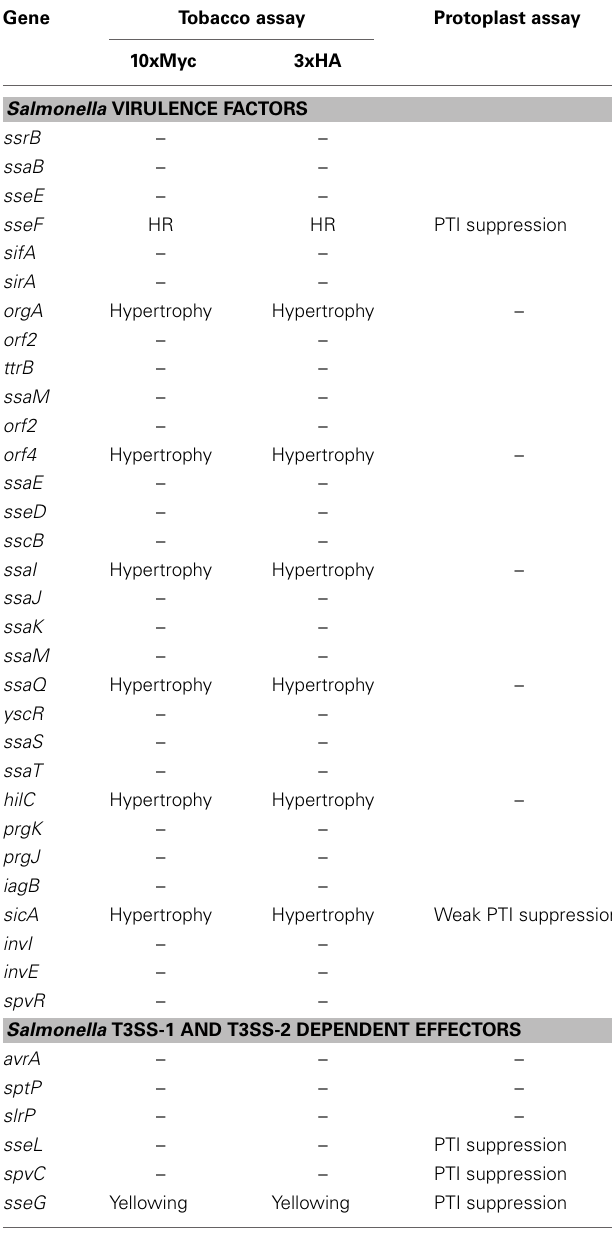
Table 1 | Salmonella ORFs cloned for screens in